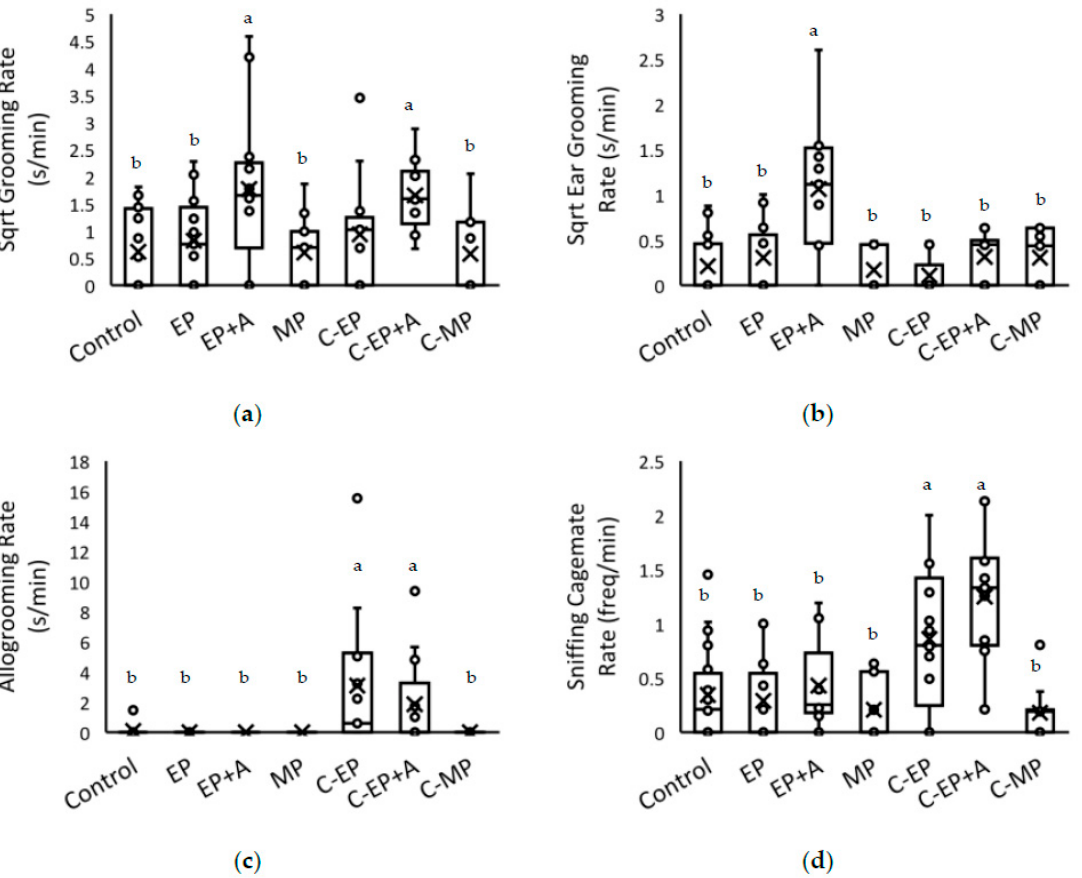
Figure 3. Immediate effects of identification marking methods on the homecage behaviour of mice and their cagemates. The behaviour was recorded for 5 min following identification marking of marked mice. General grooming of the head and body (box with bar = median +/ − IQR; x = mean) is shown in ( a ); grooming of the ears in ( b ); allogrooming of the cagemate is shown in ( c ); sniffing of the cagemate is shown in ( d ). The treatments are as follows: Control = neither mouse was marked; EP = ear-punch; EP+A = ear-punch plus anaesthetic cream; MP = permanent marker on the tail; C-EP = cagemates of EP mice; C-EP+A = cagemates of EP+A mice; C-MP = cagemates of MP mice. a Significantly greater than b ( p < 0.018, the significance threshold following controlling the false discovery